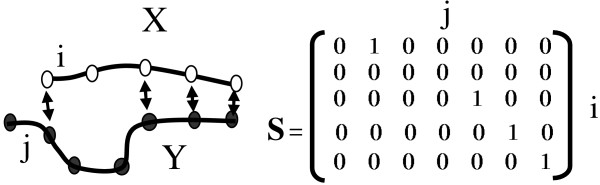
An example for two protein chains and their assignment matrix S with nx = 5 and ny = 7.